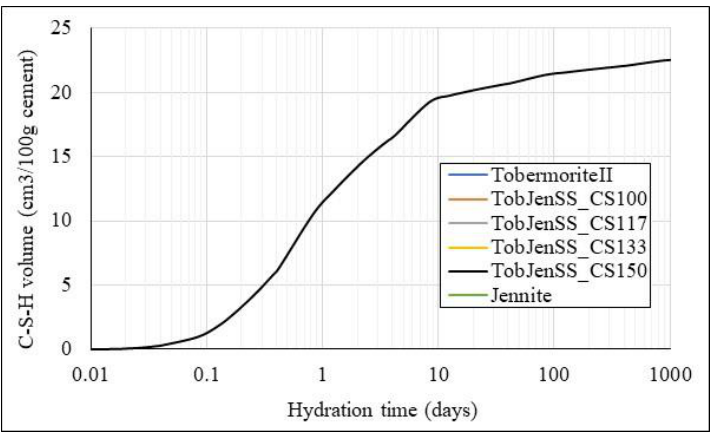
Figure 1. Predicted volume of C-S-H precipitated by each DSP.